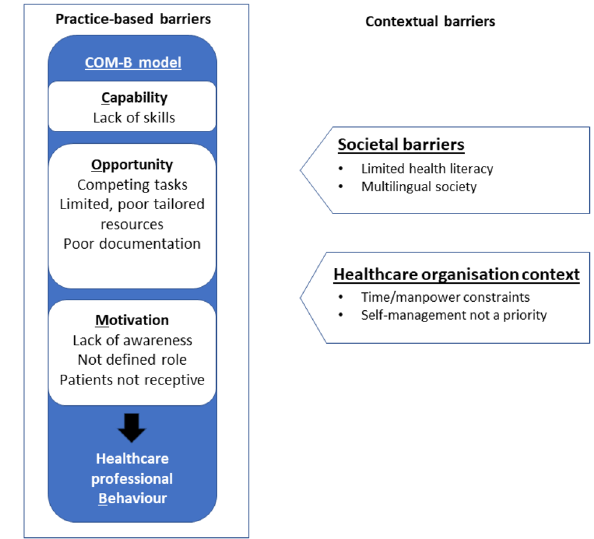
Fig. 1 Barriers to implementing asthma self-management educa- tion in primary care. Practice-based and contextual barriers to implementing asthma self-management education in primary